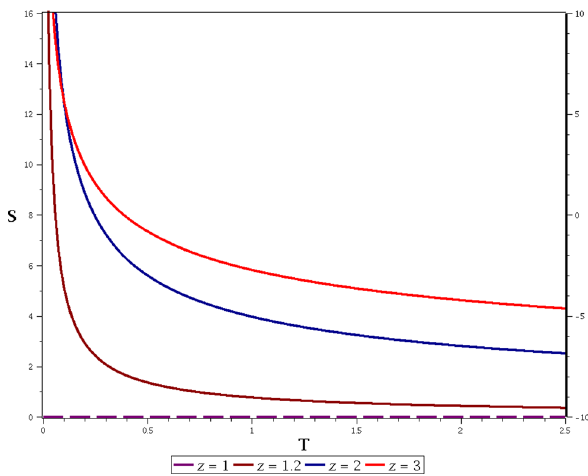
Fig. 10 Entropy as function of the temperature for the fixed values D = 5, V = 1, κ = 1 and b = 1. T and S are as in the restricted parameter case (73). It is displayed how configurations with z > 1 away from isotropic scaling are favorable with higher entropy